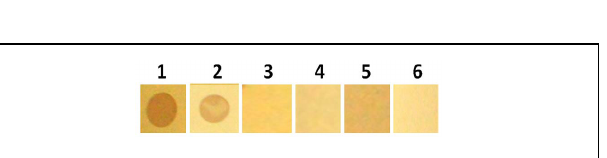
FIGURE 4 | Specificity of s-dot ELISA. 1-OTA; 2-OTB; 3-AFB1; 4-FB1; 5-DON; 6-PBS (negative control).